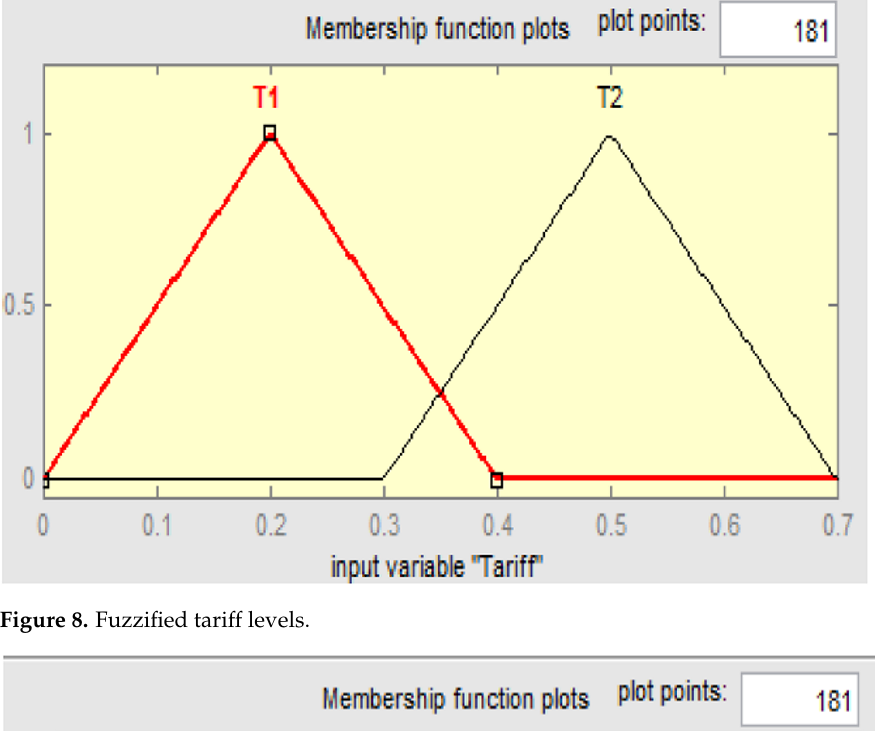
Figure 8. Fuzzified tariff levels.